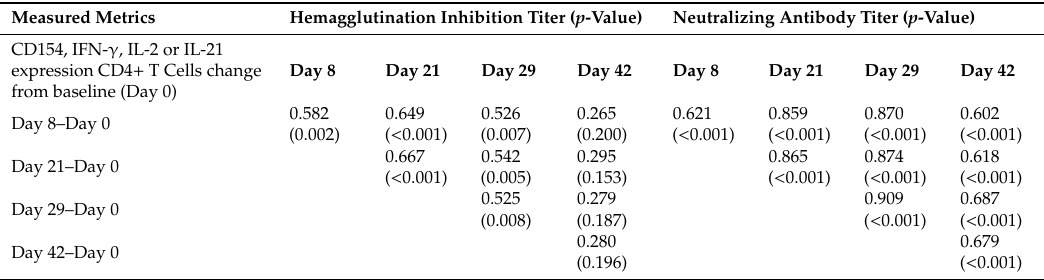
Table 6. Correlation of post vaccination CD4 + T cell responses with serum antibody responses. Measured Metrics Hemagglutination Inhibition Titer ( p -Value) Neutralizing Antibody Titer ( p